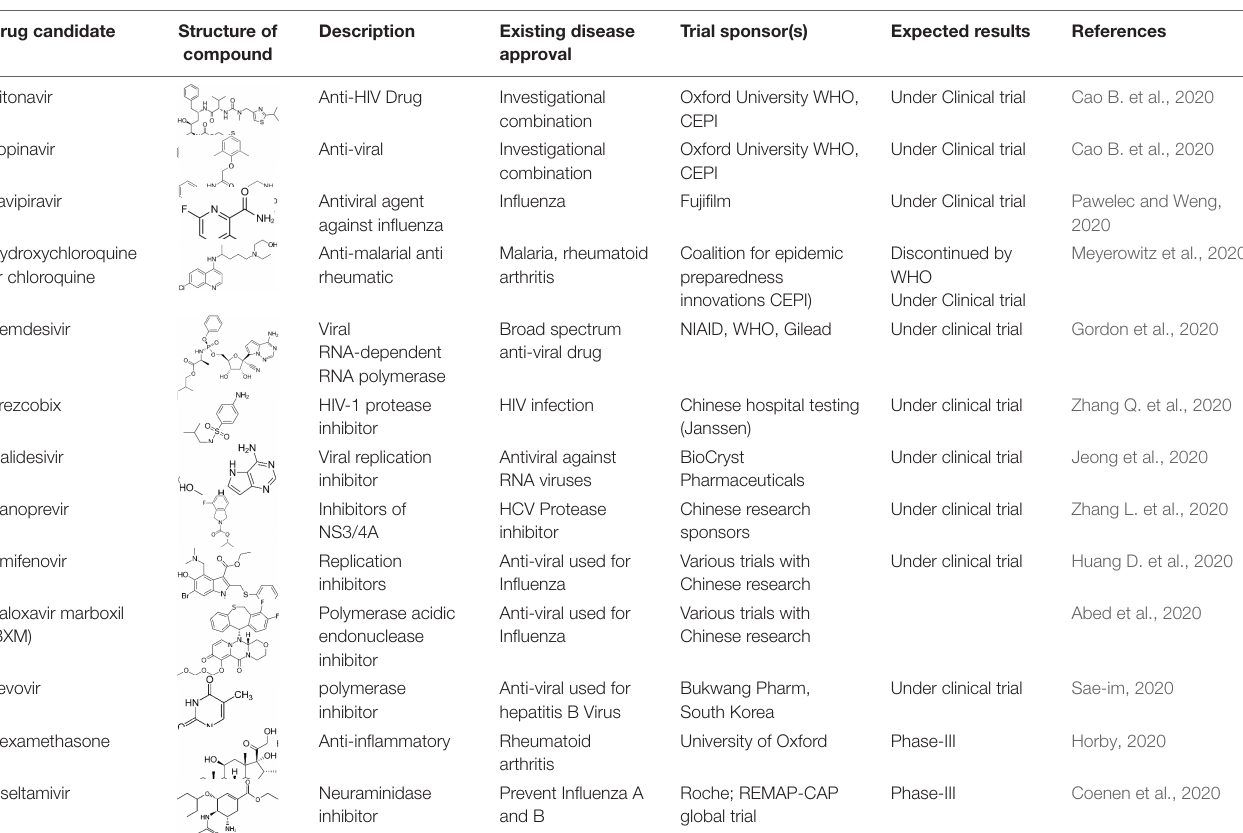
TABLE 2 | SARS-CoV-2 candidate drug treatments in Phase III-IV